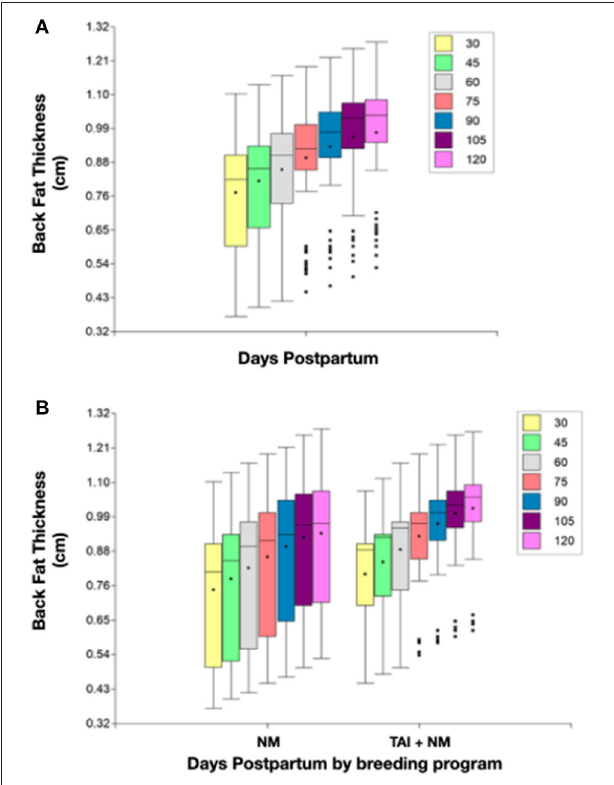
FIGURE 2 | Descriptive statistics for BFT at different days postpartum for the total of cows (A) and by breeding program (B)